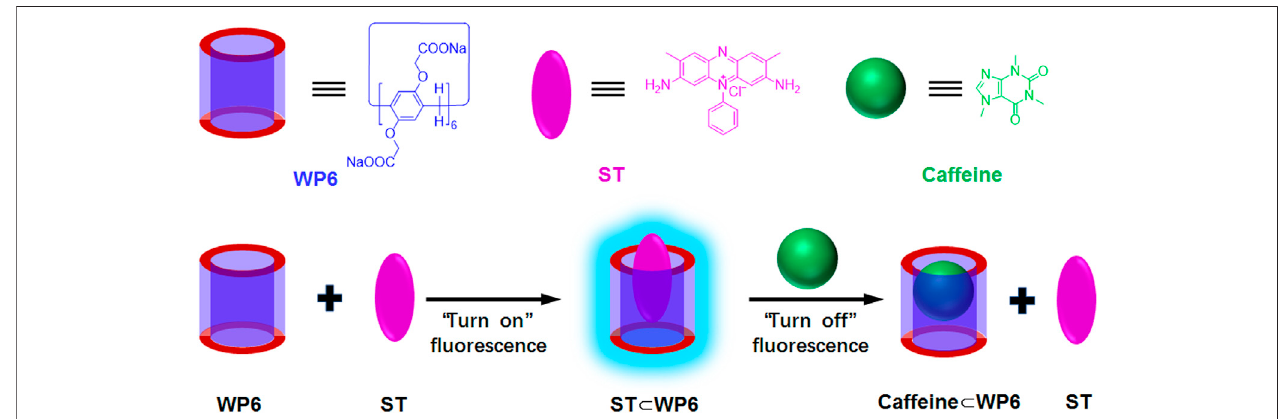
FIGURE 1 | Partial 1 H NMR spectra (400 MHz, D 2 O:DMSO- d 6 (cid:1) 1:1, 298 K) for (A) 3 mM WP6, (B) 3 mM WP6 and 10 mM ST, (C) 10 mM ST.